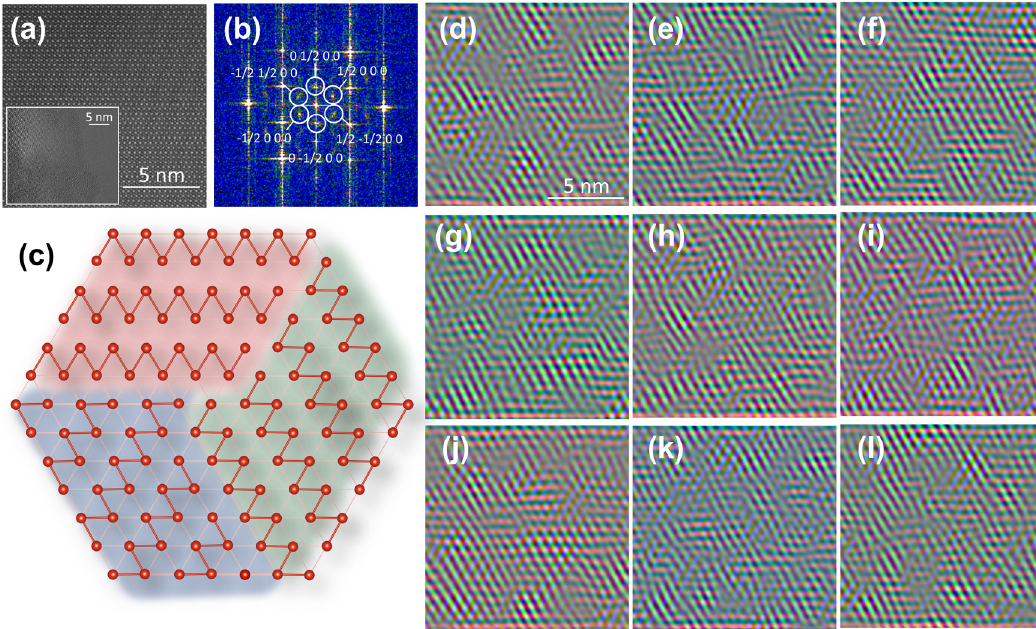
Fig. 3 ADF-STEM. a High-resolution ADF-STEM image on the edge region observed along the [0001] incidence at room temperature. Inset shows a real space image of a small LiVS 2 piece observed at room temperature. b Fourier transform pattern of the ADF-STEM image. c Schematic of existing zigzag chain patterns. Potential patterns are resonating possibly due to thermal fl uctuations. Please see the main text for more details. d – l Time series of Fourier-masked ADF-STEM images obtained at intervals of almost one second. The corresponding movie fi le is available (Supplementary